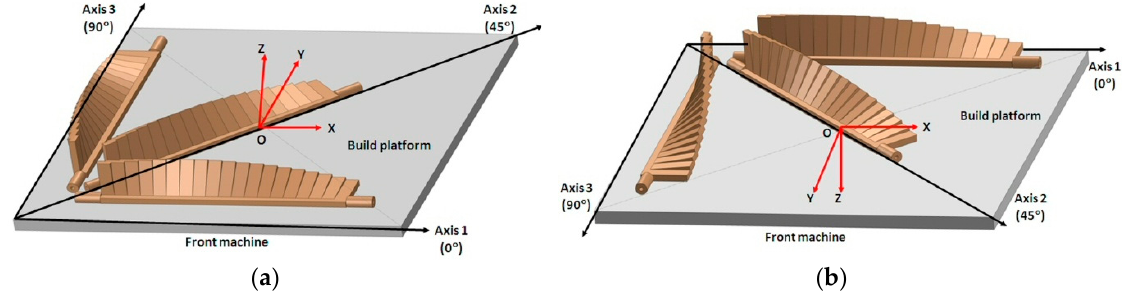
Figure 4. Layout of the build platform illustrating basic artifact orientations for ( a ) upward building additive manufacturing (AM) systems, and ( b ) downward building AM systems